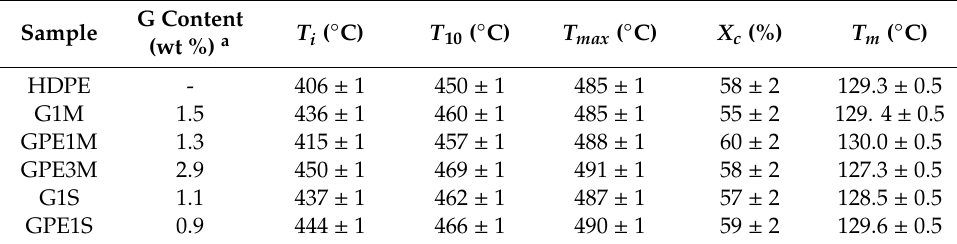
Table 1. Thermal parameters obtained from TGA and